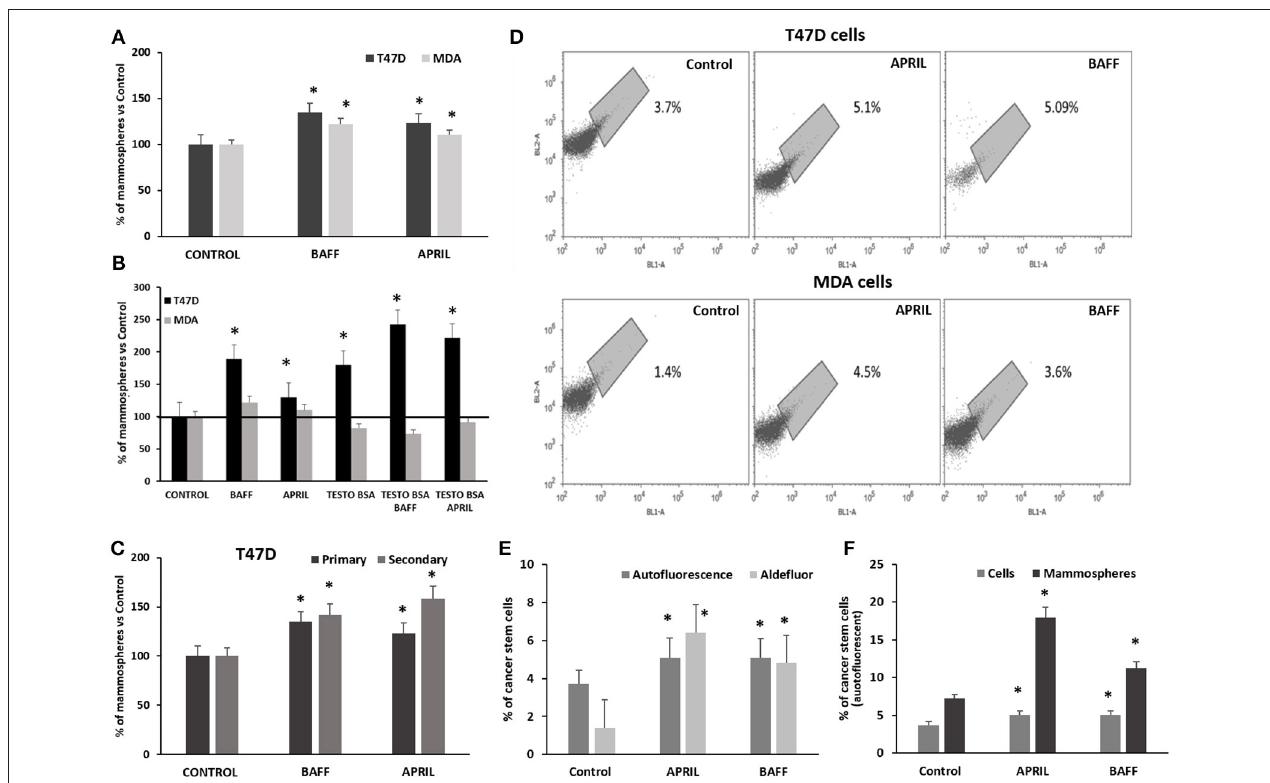
FIGURE 3 | Effect of APRIL and BAFF on mammosphere formation and breast cancer stem cell population and of testosterone on the effect of APRIL and BAFF on mammosphere formation (A). Percentage of primary mammospheres formed after treatment of breast cancer cells (T47D and MDA) with either BAFF or APRIL (100ng/ml) for 9 days. Results of three independent experiments are expressed as a percentage of control (untreated) cells (mean ± SE, *denotes p < 0.05, at least). (B) Percentage of mammospheres (primary) formed after treatment of breast cancer cells (T47D and MDA) with either BAFF or APRIL (100ng/ml) in the presence or absence of testosterone-BSA, for 9 days. Results of three independent experiments are expressed as a percentage of control (untreated) cells performed (mean ± SE, *denotes p < 0.05). (C) Percentage of mammospheres formed after treatment of T47D cells with either BAFF or APRIL (100ng/ml) for 9 days (primary mammospheres) compared to secondary mammospheres and a subsequent 7-day period. Results of three independent experiments are expressed as a percentage of control (untreated) cells. (mean ± SE, * p < 0.05) (D). Percentage of breast cancer stem cells (T47D and MDA) with or without treatment with BAFF or APRIL (100ng/ml) for 4 days as estimated by assaying them with high green autofluorescence on a population of 20,000 cells, in a BL2-A/BL1-A dot plot. Three independent experiments were performed and the results of a representative one is presented. (E) Comparison of the percentages of breast cancer stem cells as estimated by autofluorescence on a population of 20,000 cells in a BL2-A/BL1-A dot plot and ALDEFLUOR kit with or without treatment with BAFF or APRIL (100ng/ml) for 4 days. Three independent experiments were performed (mean ± SE, *denotes p < 0.05). (F) Comparison of the percentages of breast cancer stem cells (identified by autofluorescence on a population of 20,000 cells in a BL2-A/BL1-A dot plot) in T47D cells and mammospheres treated or not with BAFF or APRIL (100ng/ml) for 4 and 12 days respectively. Three independent experiments were performed (mean ± SE, *denotes p <